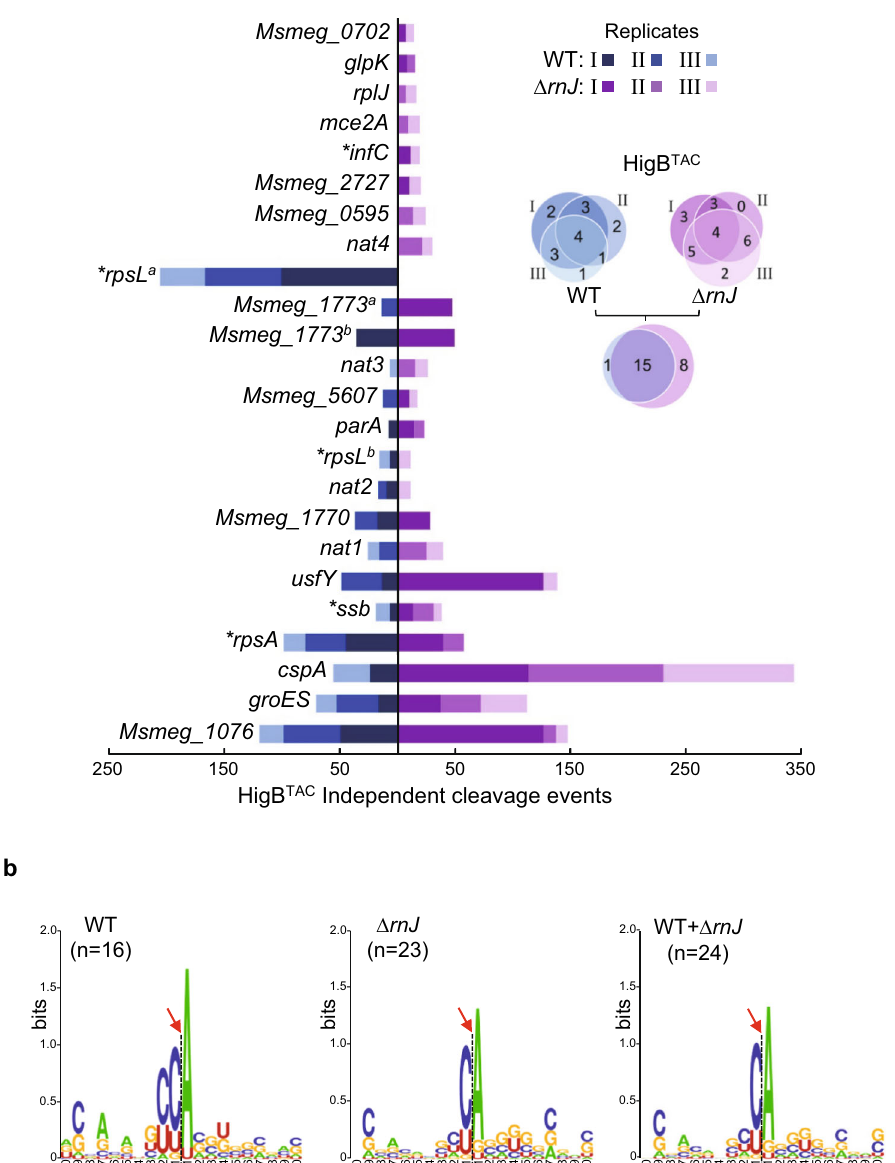
Fig. 2 HigB TAC targets and recognition sequences in vivo. a HigB TAC targets identi fi ed in vivo by nEMOTE following 3h expression in M. smegmatis WT (on the left; shade of blue; replicates I, II, and III) and Δ rnJ (on the right; shade of violet; replicates I, II, and III). Target overlaps between the replicates and between the strains are represented by Venn diagrams. Bar length represents the number of independently observed cleavage events for each unique target site ( x axis). The name of the gene of the cleaved mRNA is given on the left. The number of cleavages identi fi ed in each replicate for the WT (shade of blue; replicates I, II, and III) and the Δ rnJ mutant (shade of violet; replicates I, II, and III) is shown using the indicated color code. (*) indicates essential genes in both M. smegmatis and M. tuberculosis . b HigB TAC preferred sequence motif. Logoplots showing HigB TAC preferred motif obtained with the unique cleavage sequences identi fi ed for the WT ( n = 16), the Δ rnJ mutant ( n = 23) or both WT + Δ rnJ ( n = 24). The x axis represents the 10 nucleotides upstream and downstream of the cleavage site that is located by the position between − 1 and 1 (red arrow and dash line), and the default label for the y axis is